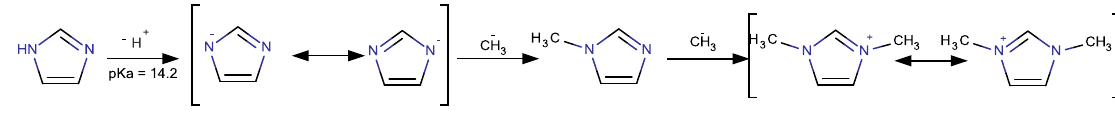
Figure 4. Synthetic path to 1,3-dimethylimidazolium (designed using the program Marvin Sketch [50]).